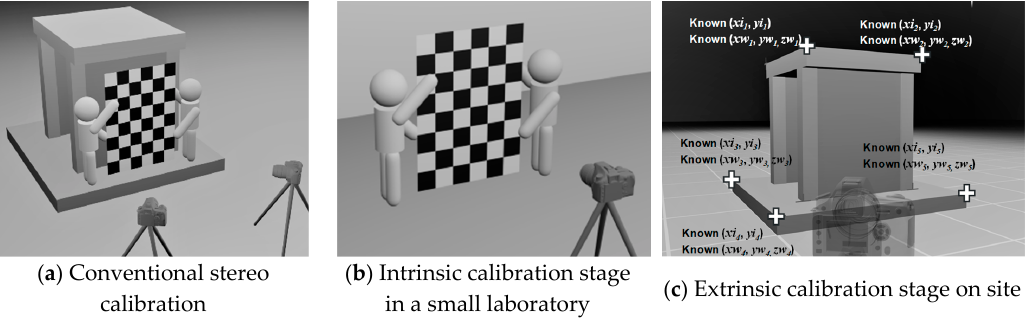
Figure 3. Different camera calibration approaches and stages. The proposed two-stage calibration includes intrinsic calibration in a small laboratory and extrinsic calibration on site. In this research, two calibration approaches are introduced to estimate the camera parameters in large-scale experiments: (1) two-stage calibration and (2) single-image calibration. The two-stage calibration approach is suitable for cases where the measurement region is so large that it is impractical to build a similar-sized calibration board. In this approach, the intrinsic parameters and the extrinsic parameters are calibrated separately. Intrinsic parameters are calibrated in a relatively small laboratory by taking photos of a calibration board which does not need to be the same size of the large specimen (see Figure 3b). Without changing camera settings (e.g., focal lengths, focusing distance, etc.), re-positioning a camera does not change its intrinsic parameters. The extrinsic